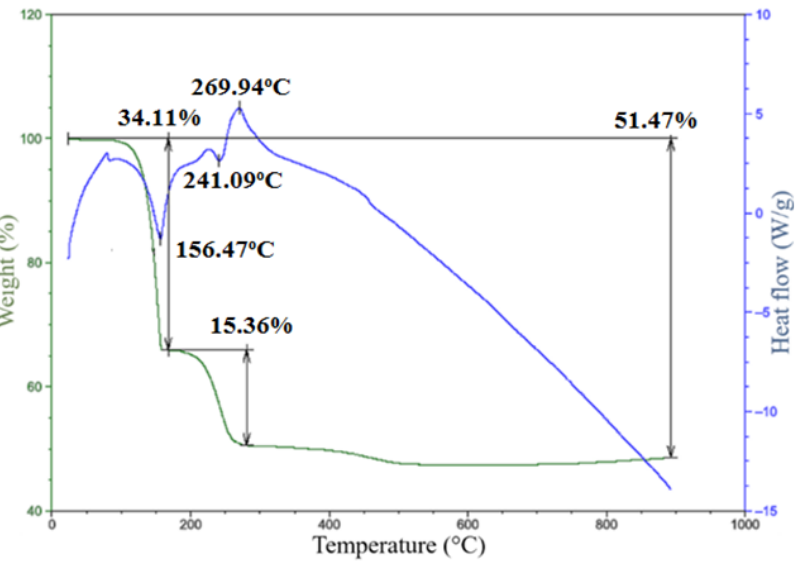
Figure 3. Thermogram of 1 .